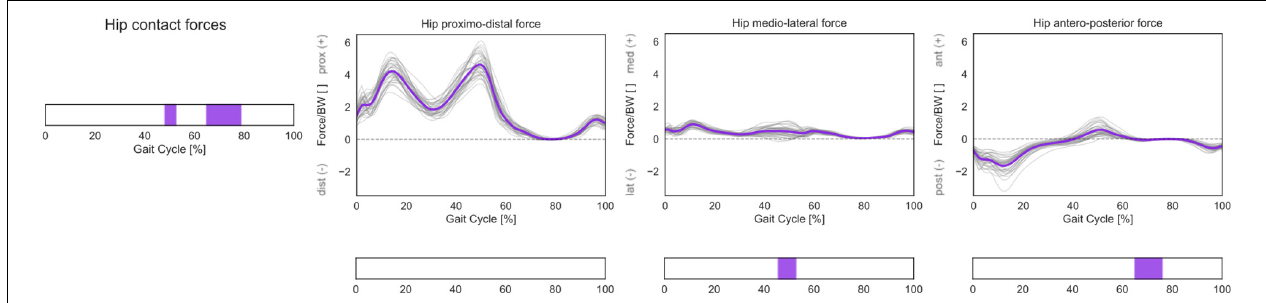
FIGURE 8 | 3D HCFs over the GC. HCFs were calculated in a proximal (pelvis-based) coordinate system according to ISB recommendations and are normalized by body weight (BW). Average profiles for each subject are reported in gray, while the cohort’s mean is reported in violet. Phases of GC in which a statistically significant correlation was observed in the SPM vector-field CCA are indicated in the leftmost panel. Below each force component, the results of the post hoc scalar-field linear regression analyses are reported.